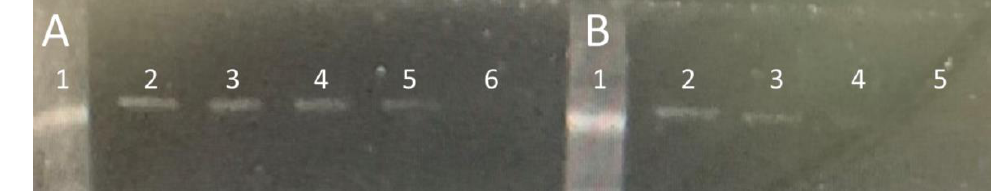
Figure 6. SDS gage for optimization of binding of Bocillin FL and PBP2x* imaged ChemiDoc-It®2 Imager. ( A ) Lane 1: protein marker 70 kDa band (PageRuler Pre-stained NIR Protein Ladder (Thermo Fisher Scientific (Waltham, MA, USA)), lanes 2-6: Binding reaction of 1 µM of Bocillin FL with 1, 0.5, 0.25, and 0.1 µM of soluble PBP2x*, respectively. ( B ) Lane 1: Protein marker, lanes 2-5: Binding